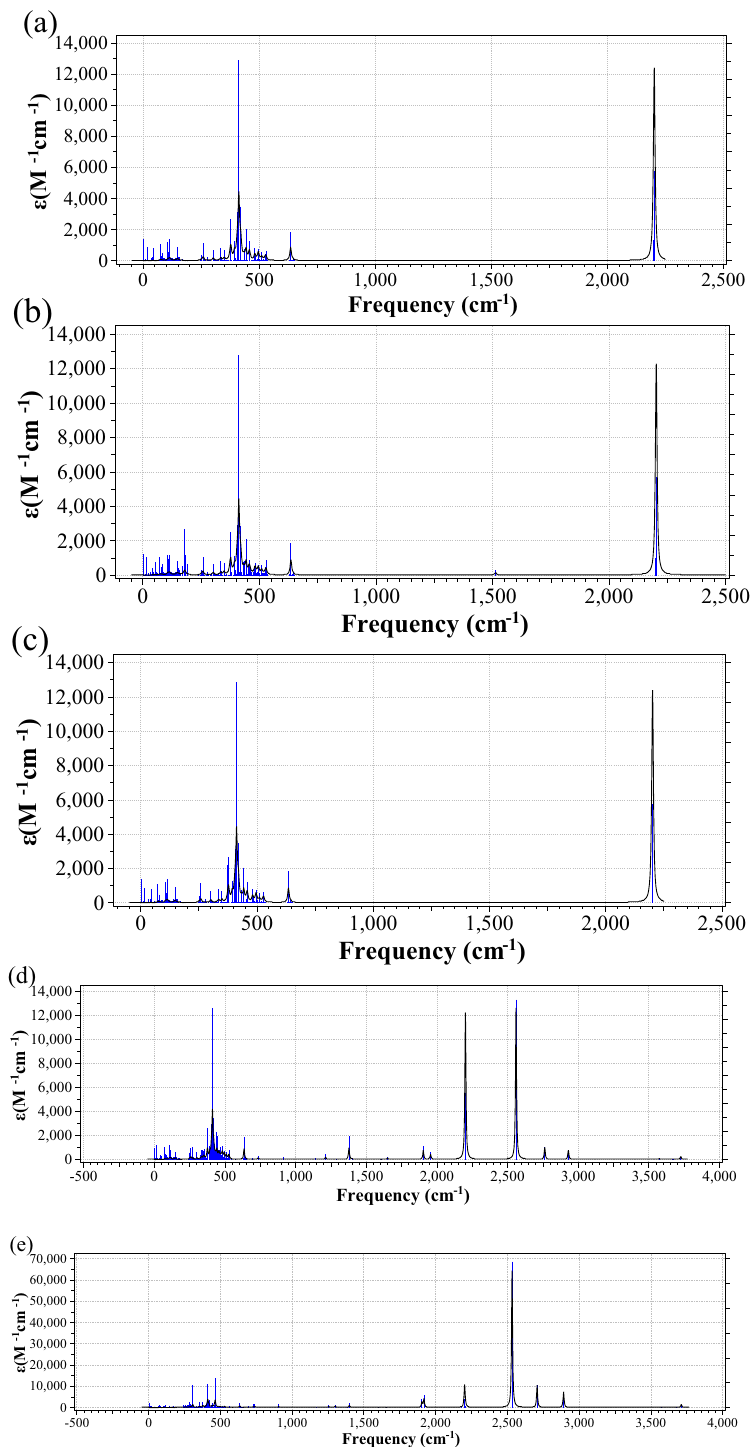
Figure 7. The IR spectra (in the unit of cm −1 M −1 ) as a function of vibrational frequencies (in the unit of cm −1 ): ( a ) the 5 × 5 SND, ( b ) a single water molecule on the centre of the 5 × 5 SND, ( c ) a single water molecule on the edge of the 5 × 5 SND, ( d ) a square ice on the centre of the 5 × 5 SND, and ( e ) a square ice on the edge of the 5 × 5